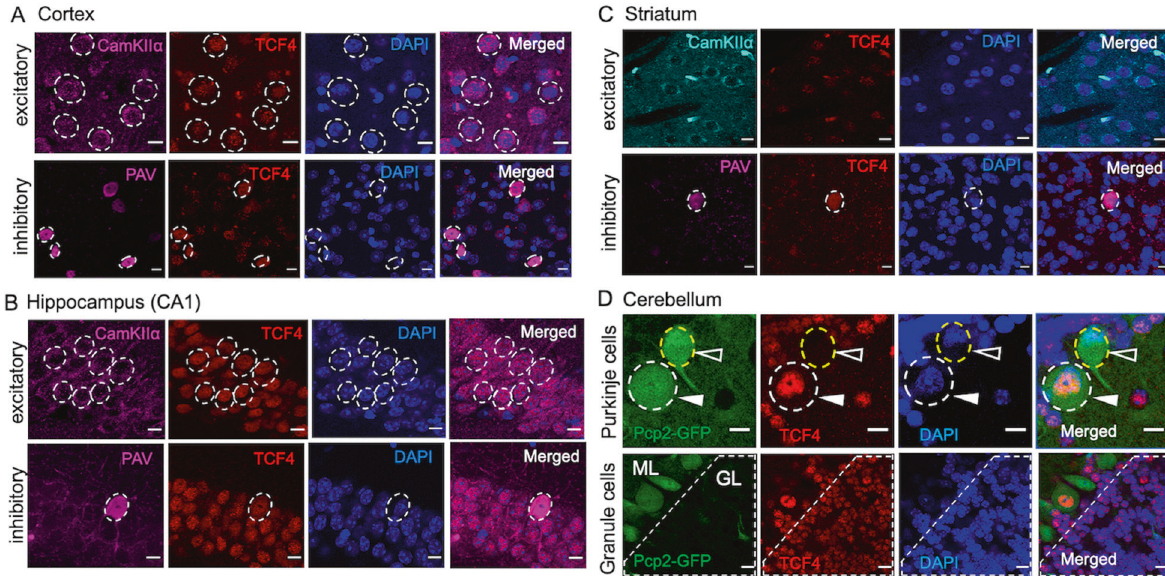
Fig. 1 Tcf4 protein expression in excitatory and inhibitory neurons in adult brain. Representative immuno fl uorescence images showing Tcf4 protein expression in the nucleus of excitatory and inhibitory neurons in A cortex, B hippocampus (CA1 region), C striatum (caudate putamen) and D cerebellum; solid arrow: TCF4 + PC, empty arrow: TCF4 − PC; PC Purkinje cells, ML molecular layer, GL granule cell layer (shown in dash-lined box), representative of 3 – 5 adult mice. Scale bar = 10